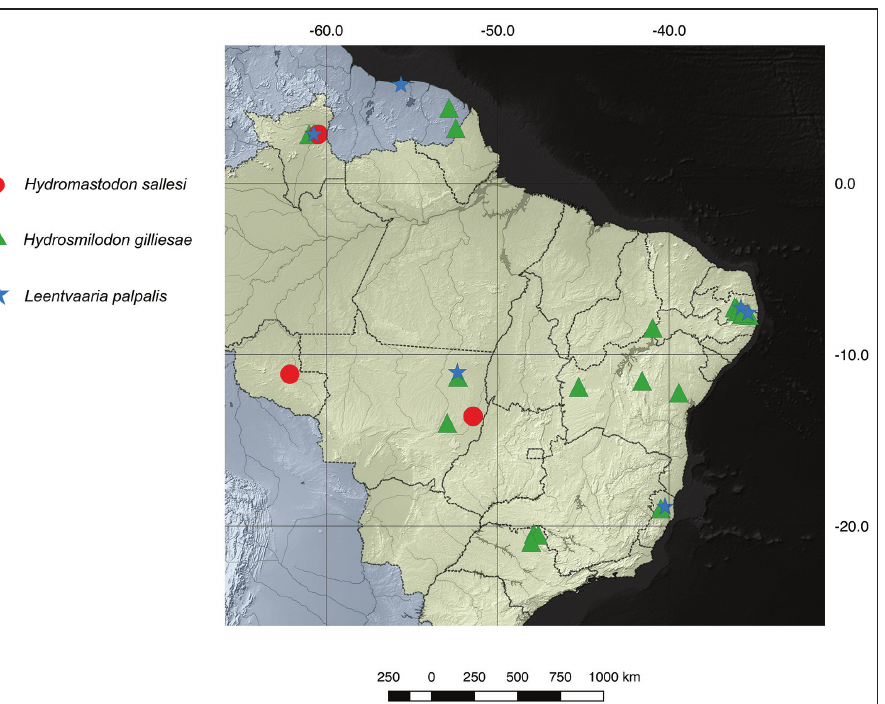
Figure 9. Partial view of South America, with emphasis on Brazil (yellow), showing the distribution of the species treated herein. Dashed lines, Brazilian states